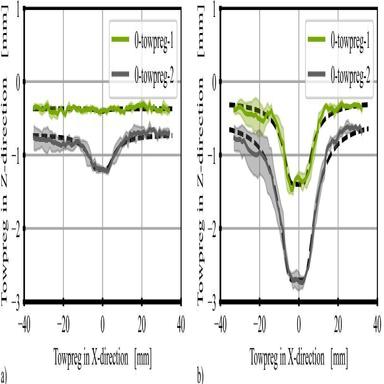
Experimentally measured waviness at cross-sections and fitting with the exponential power distribution of 0-towpregs for 0/90 (a) and combined towpreg design (b). (The solid line, shaded region, and black dashed line mean the average values, standard deviation and fitted exponential power distribution, respectively).